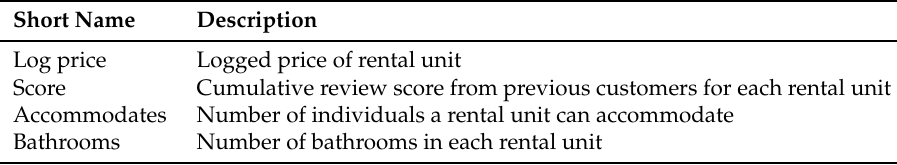
Figure 2. 2203 rental properties in the Prenzlauer Berg neighborhood of Berlin. Note: basemap and scalebar added using additional code. Table 2. Berlin